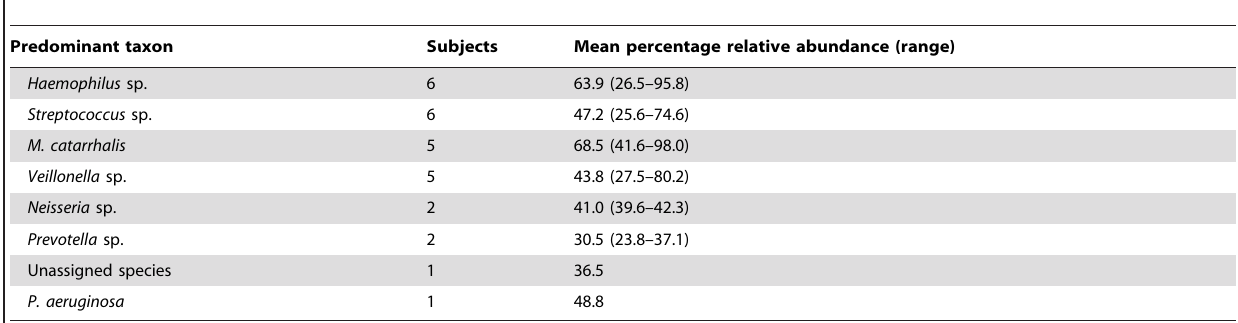
Table 2. Number of subjects and mean percentage abundance of different bacterial species present within induced sputum samples.